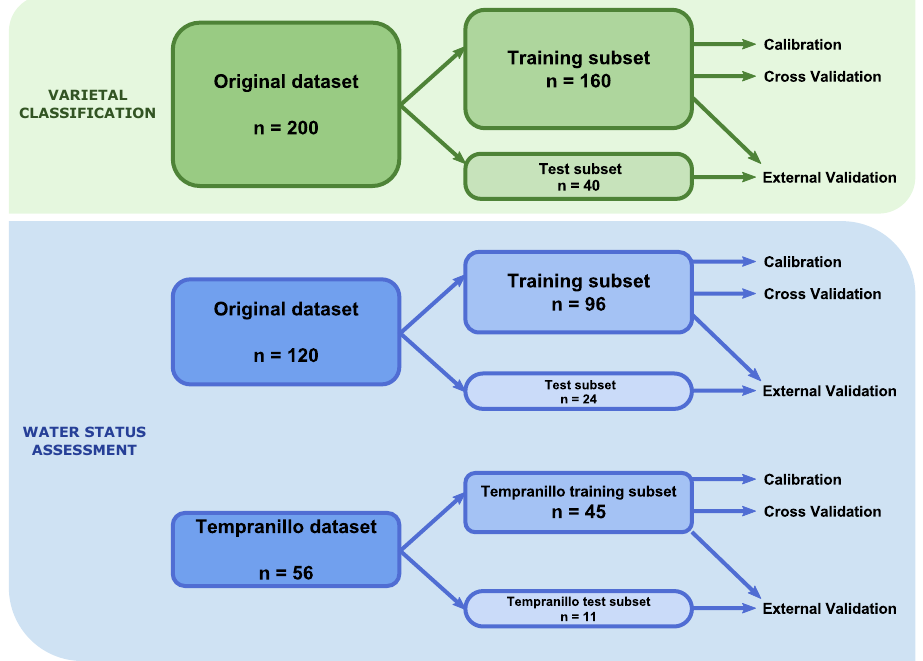
Figure 1. Diagram of the datasets used in both experiments and the different calibration and validation